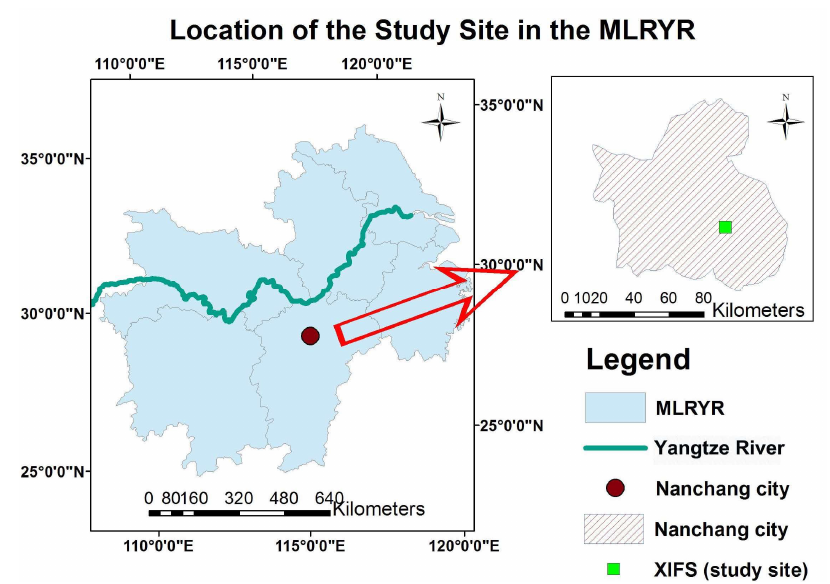
Figure 1. Location of the study site in the Middle and Lower Reaches of Yangtze River 132